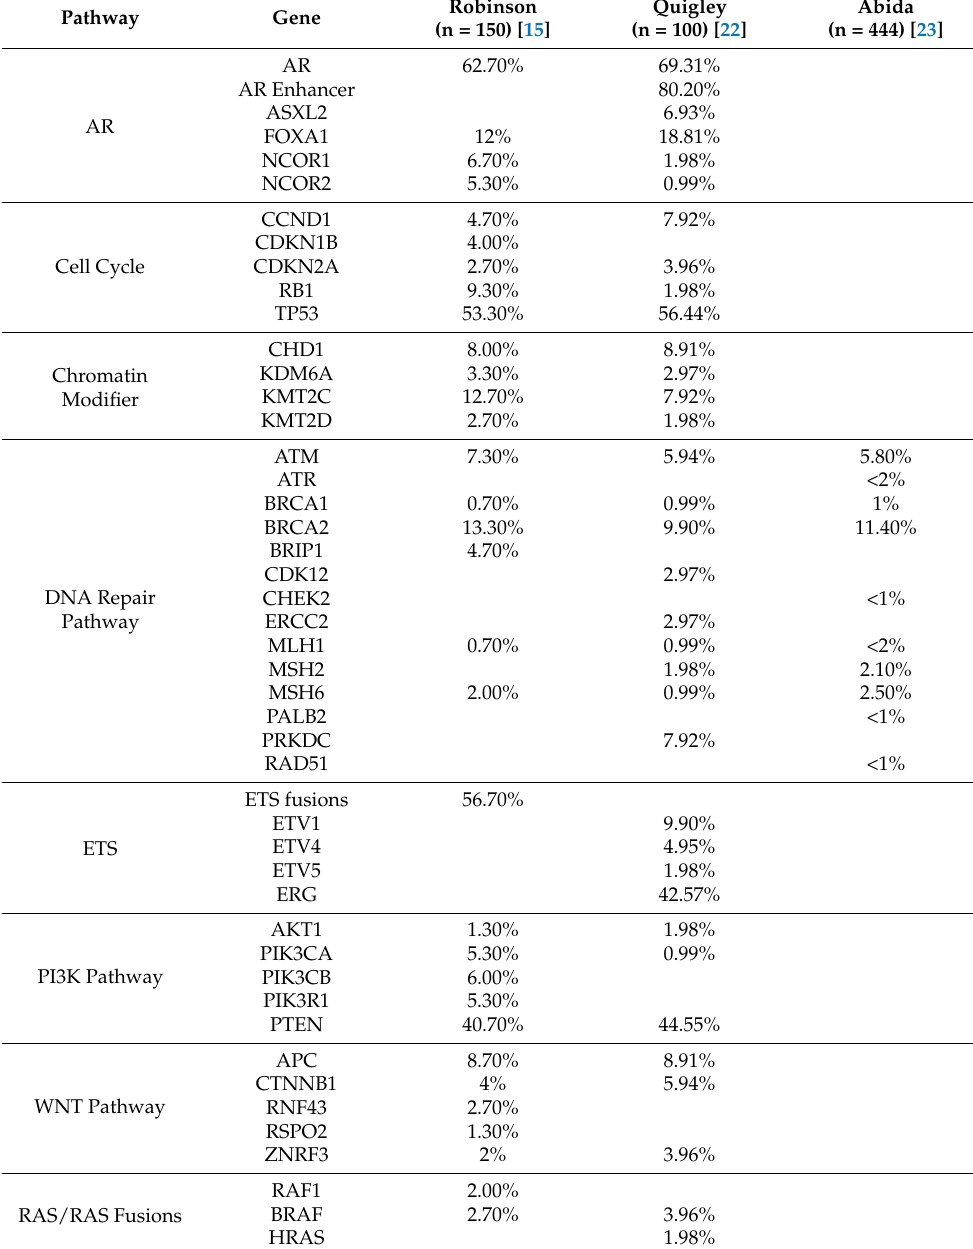
Table 2. Summary of reported somatic genetic aberrations in